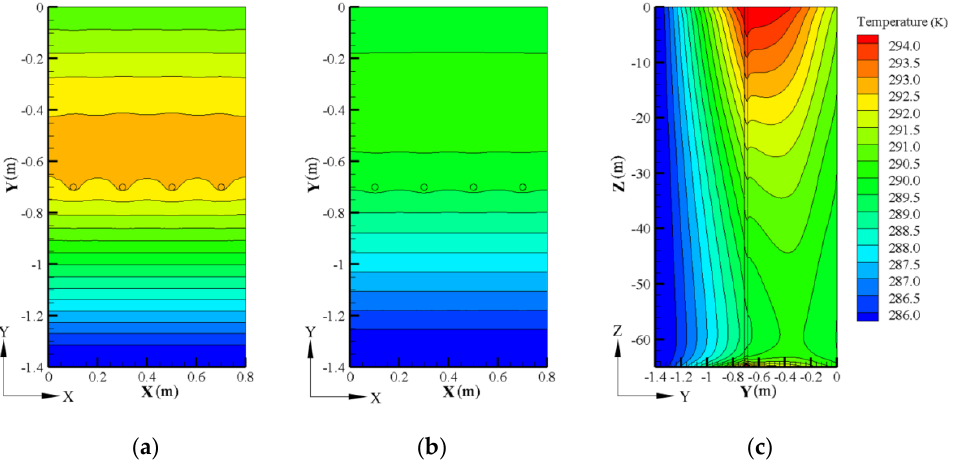
Figure 24. Simulated soil temperature distribution at 16:00 on 6 January 2020. ( a ) Z = − 15 m, ( b ) Z = − 50 m, ( c ) X = 0.3 m (the X-to-Y ratio is set as 20).